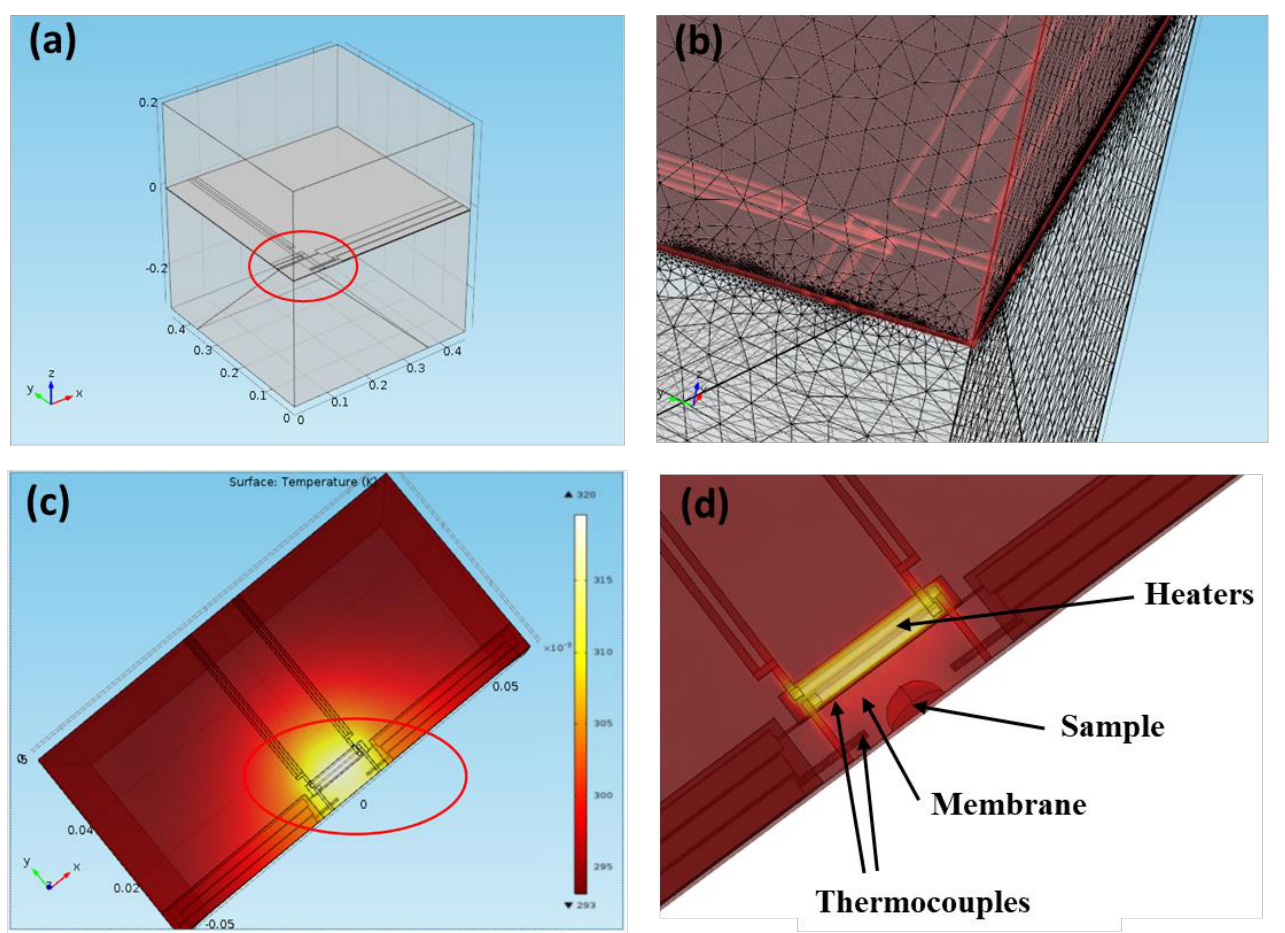
Figure 2. Modelling of the temperature distribution during AC heating for the gas sensor. ( a ) Ge- ometry of the gas sensor with 100 × 100 µm 2 active area; ( b ) FEM net built using Comsol TM ; ( c ) Mod- elling of the temperature distribution during AC heating using two resistive heaters connected in series; ( d ) zoomed-in sensor area with a sample.